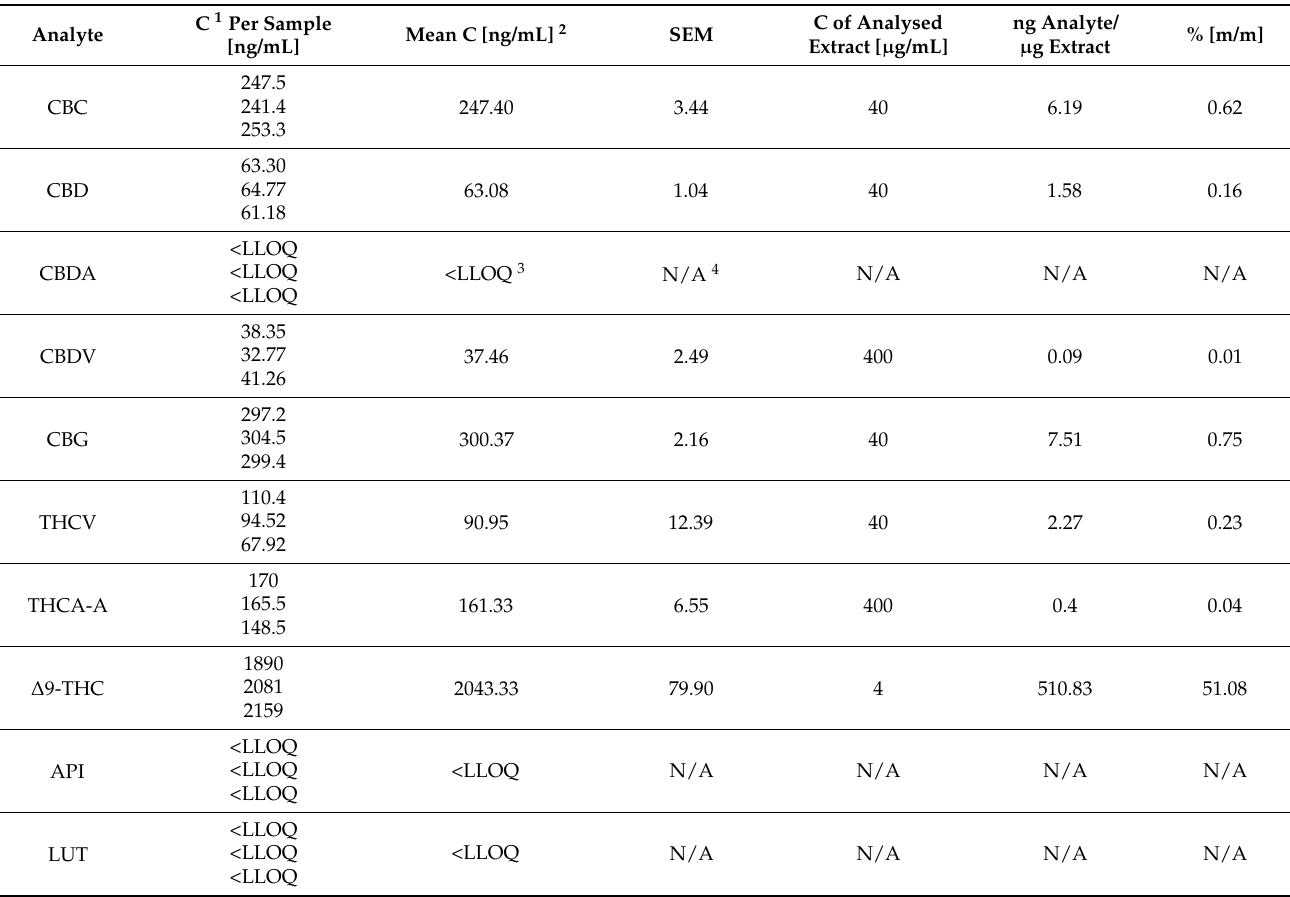
Table 2. Quantification of cannabinoids and flavonoids in THC +